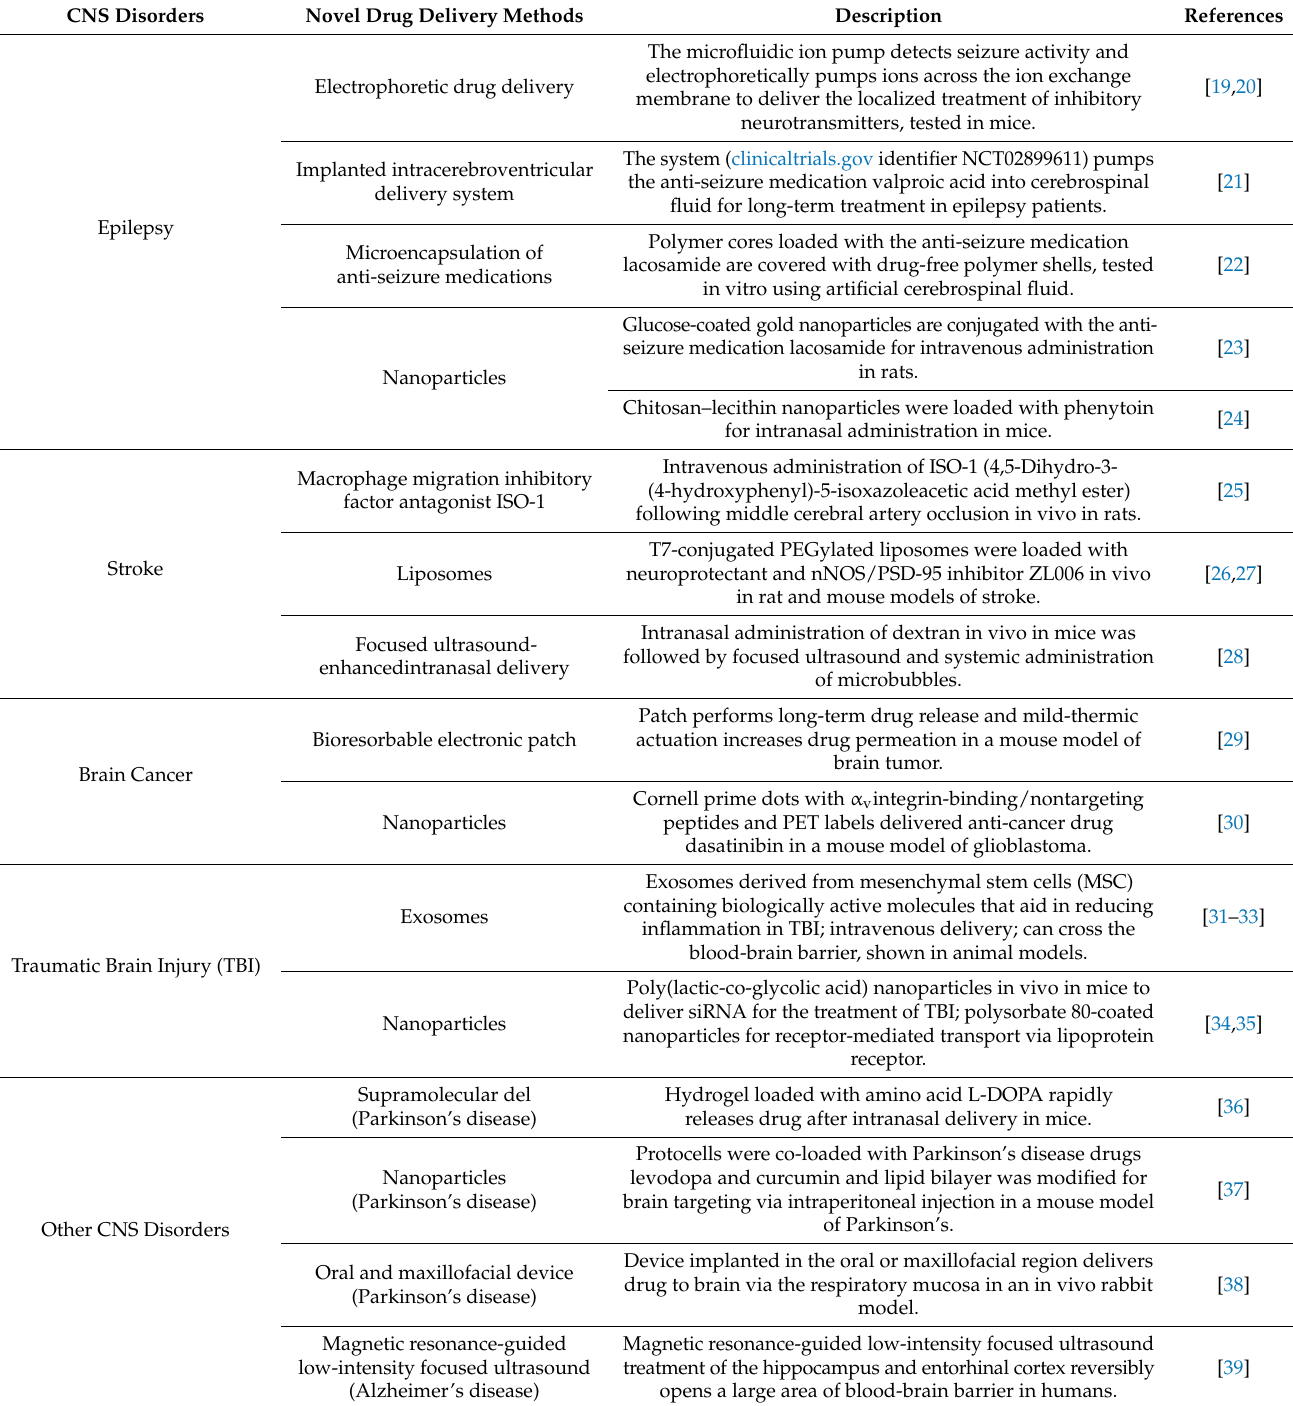
Table 1. Featured novel drug delivery methods in central nervous system disorders in human and animal